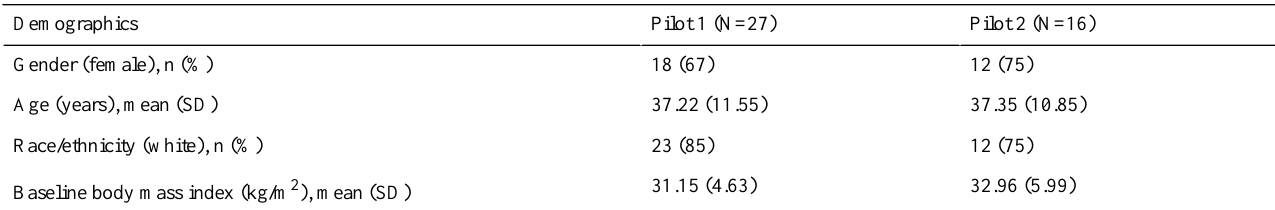
Table 2. Participant characteristics in pilots 1 and 2.